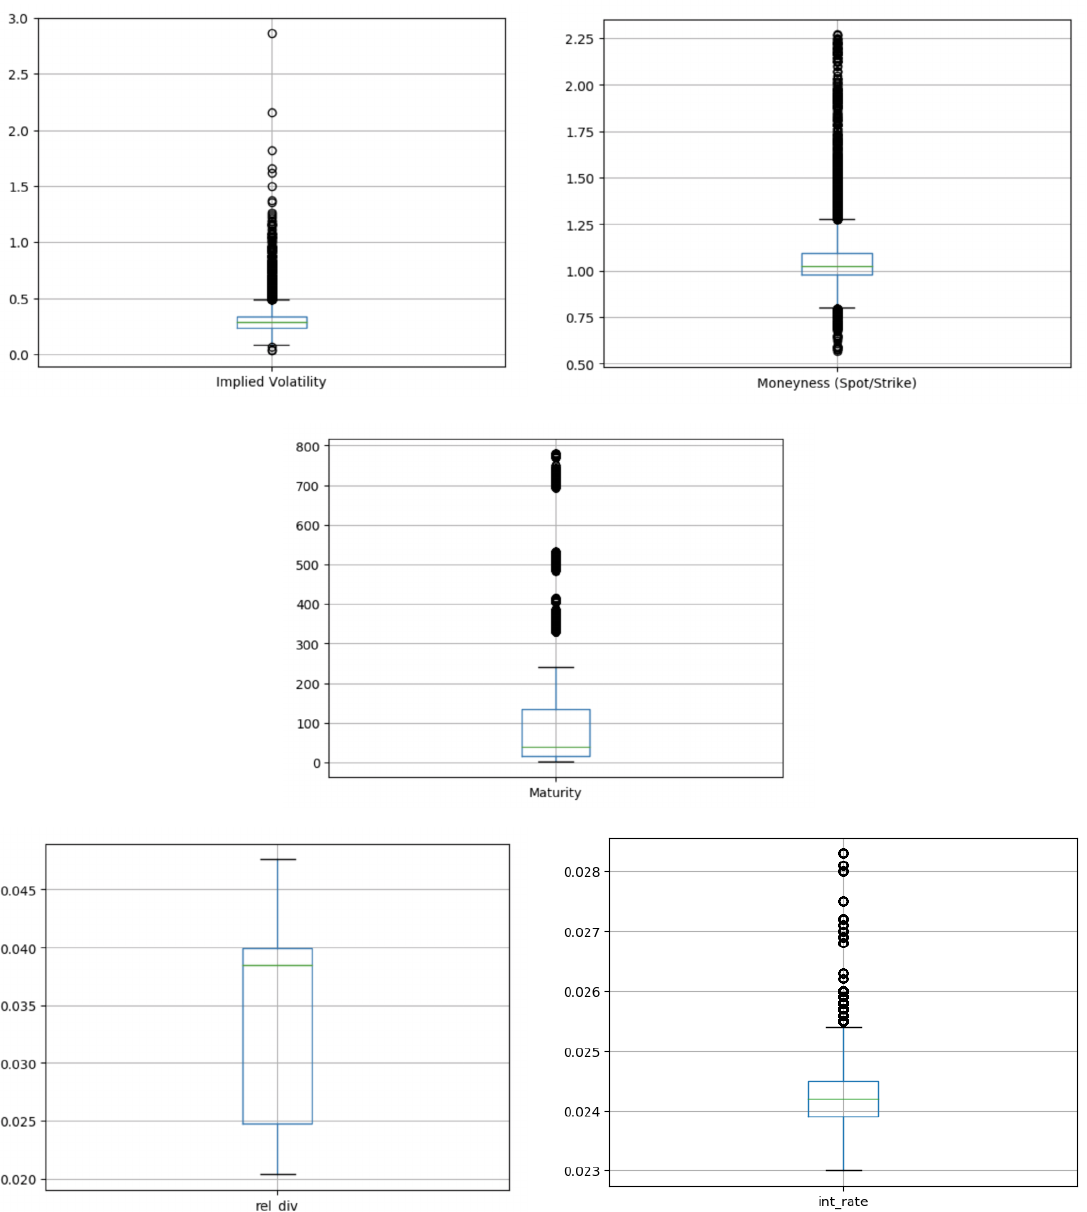
Figure 4. Boxplots of the input